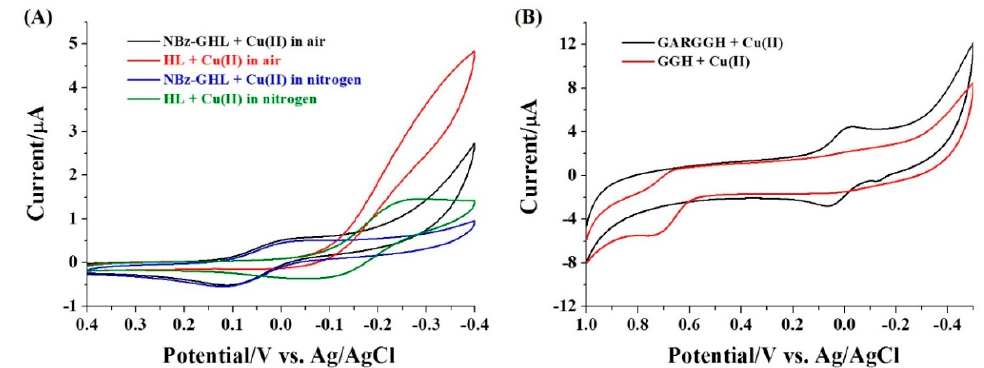
Figure 2. CVs of Cu(II) in air or nitrogen-saturated solution with the addition of different peptides: ( A ) NBz-GHL and HL; ( B ) GARGGH and GGH. The final concentrations of peptide and Cu(II) were 100 μ M. The scan rate in panel A is 20 mV/s and that in panel B is 100 mV/s.